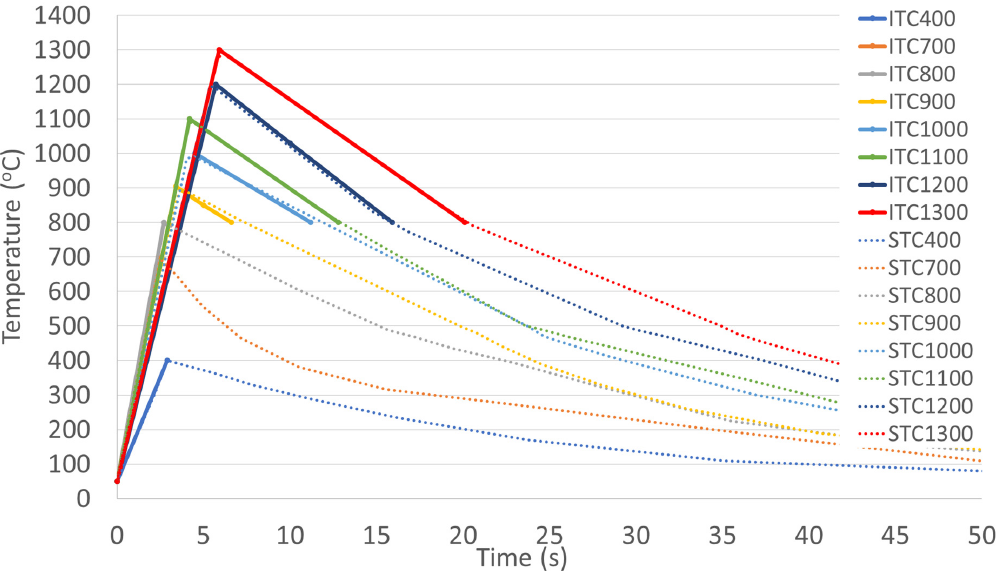
Figure 5. Forcing cycles (ITC) and calculated (STC) inside the heat-affected zone (HAZ) for thermal cycles with the maximum temperature from 400 to 1300 °C (Table 3).